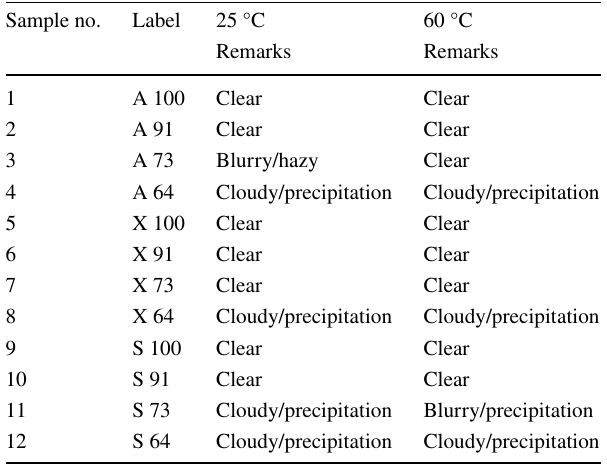
Fig. 3 Time needed to gener- ate 100 ml foam for different surfactant solutions with and without foam booster (LB) at a 25 °C and b 60